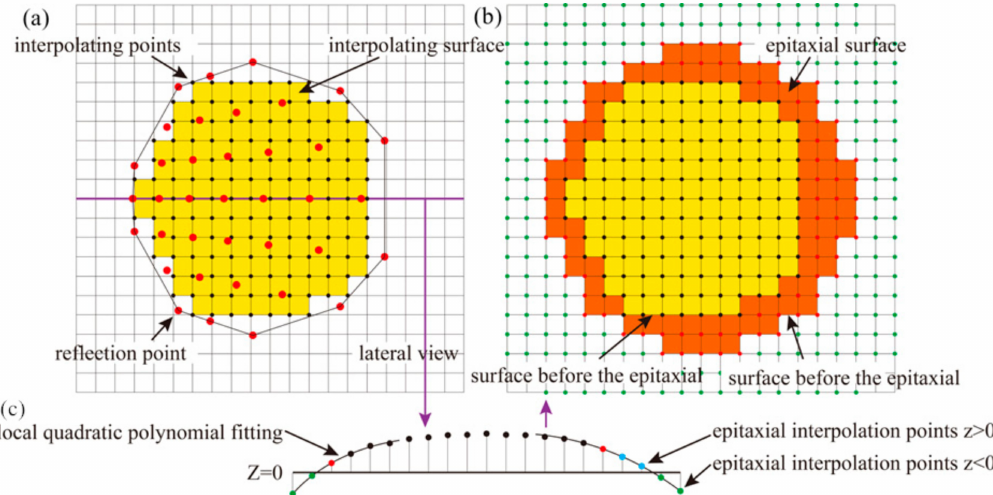
Figure 6. The schematic diagram of the boundary extension. ( a ) The interpolation result of Figure 2a; ( b ) The epitaxial surface by using the local quadratic polynomial fitting method; ( c ) The lateral view of a raw after the local quadratic polynomial fitting.